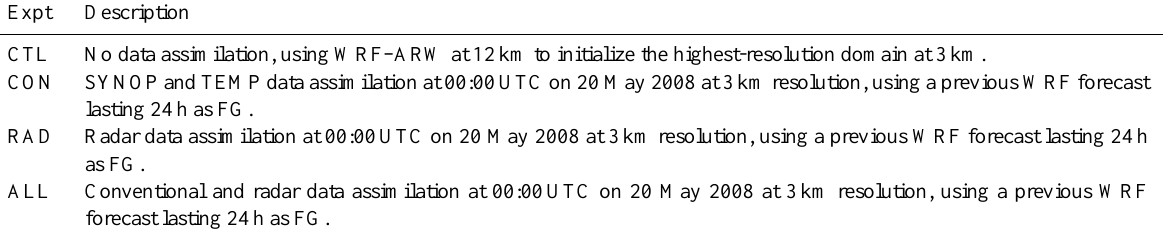
Table 1. List of experiments and related description. Expt Description